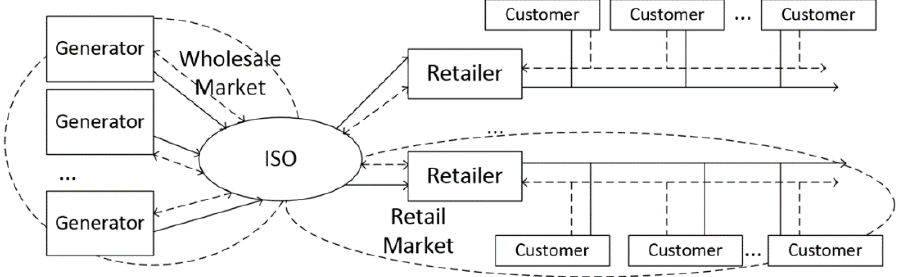
Figure 1. The structure of electricity market.